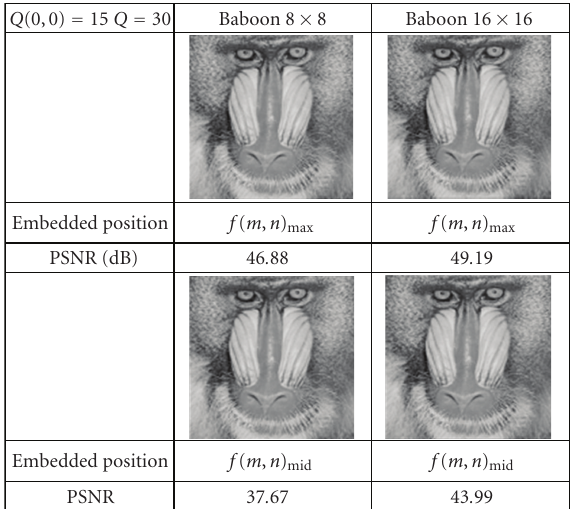
Figure 6: The ROI image embedded into an original image in various conditions.